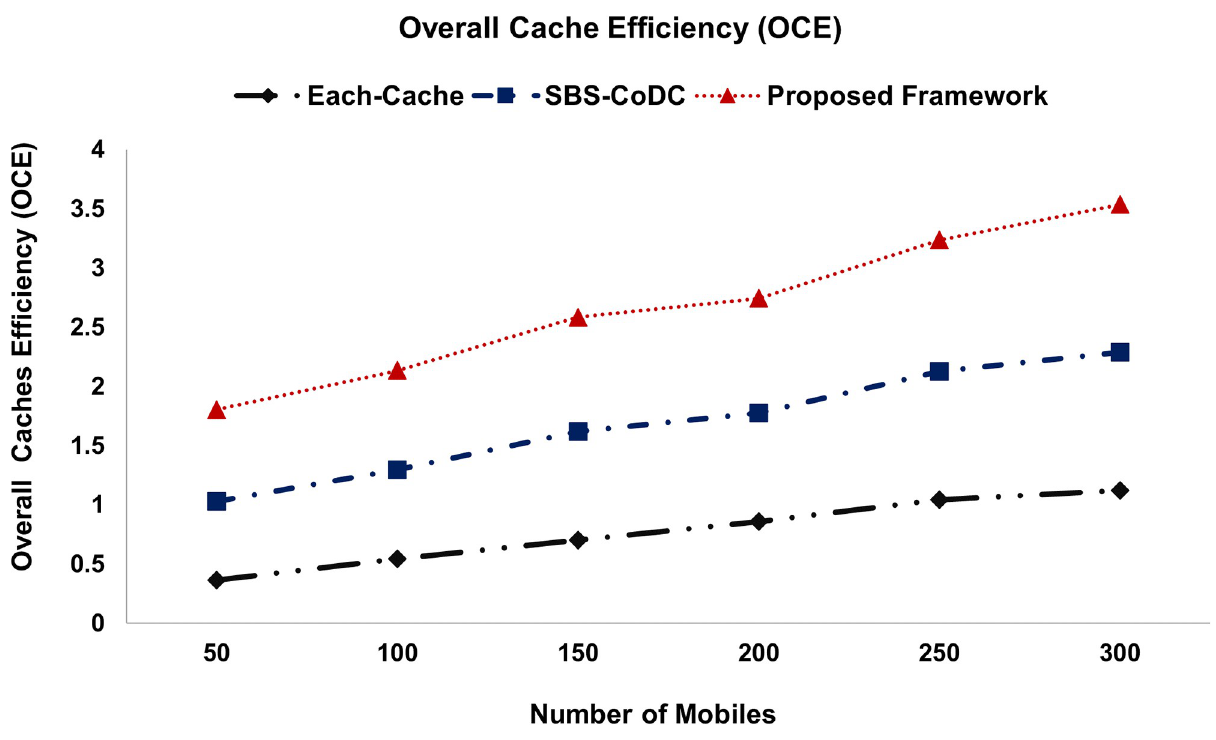
Fig 17. Comparison overall distributed cache